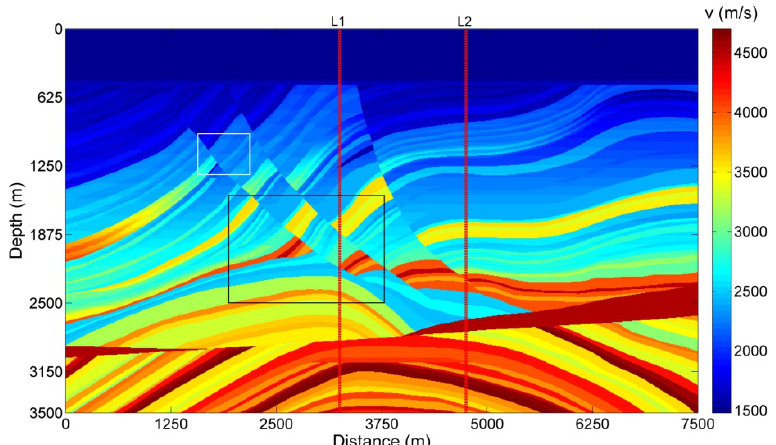
Figure 4. The velocity field of the Marmousi model. The red lines show the locations of log L1 and log L2.